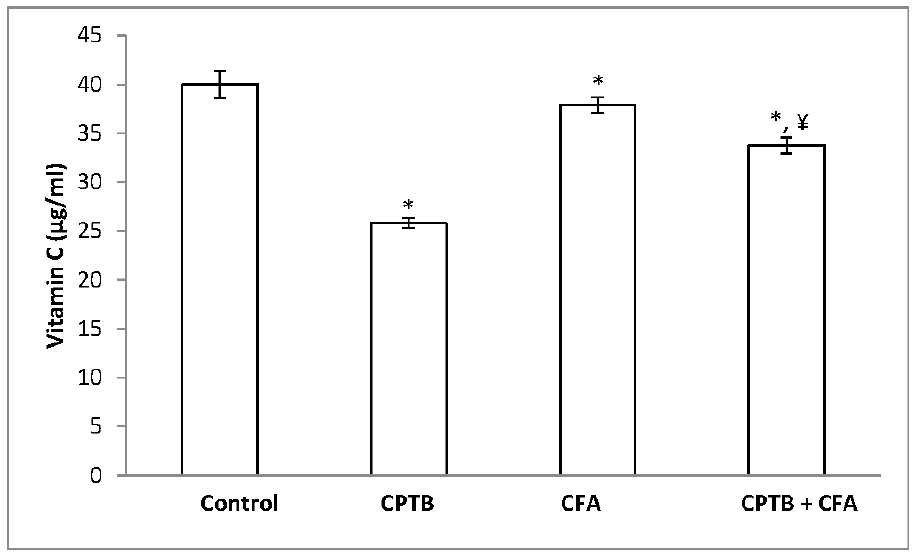
Figure 4. Protective effect of caffeic acid on the reduction of hepatic ascorbic acid (vitamin C) levels in rats due to capecitabine-induced toxicity. Data are expressed as means ± SD for six rats in each group; * significantly different from the control ( p < 0.05); ¥ significantly different from the capecitabine group ( p < 0.05).